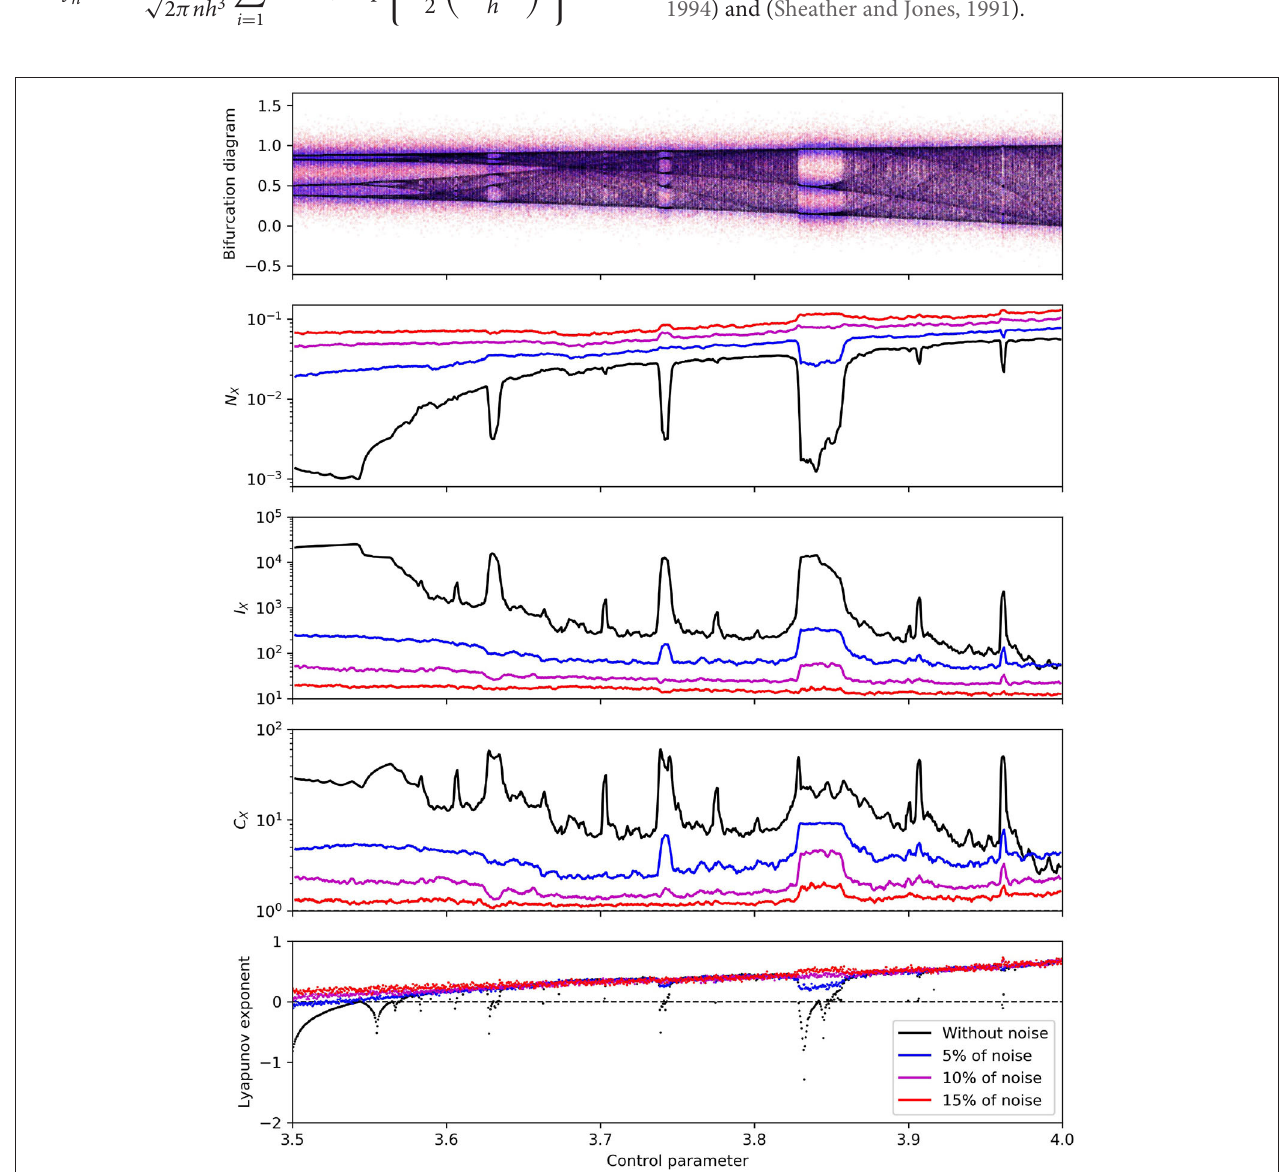
FIGURE 2 | Logistic map with different level of noise. From top to bottom : bifurcation diagram, SEP, FIM, FSC, and Lyapunov exponent sliding windows. Note the logarithmic scale on the y-axis for SEP, FIM, and FSC.